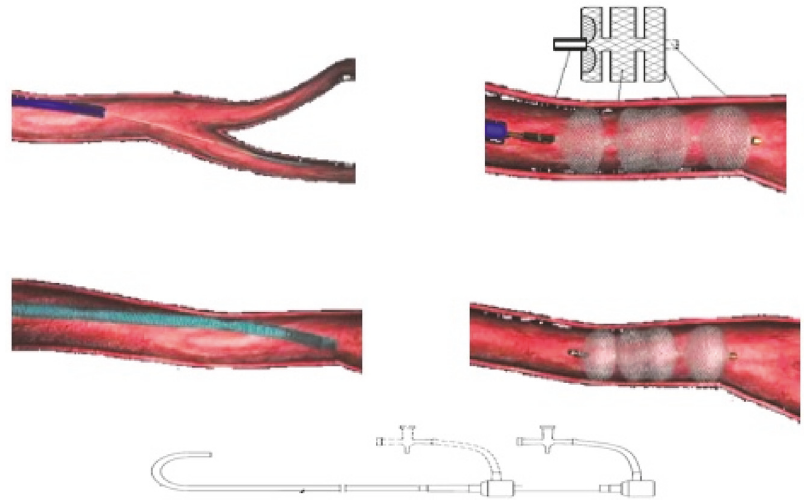
Figure 1: An actual picture of plug device (Starway, Cardi-O-Fix Plug